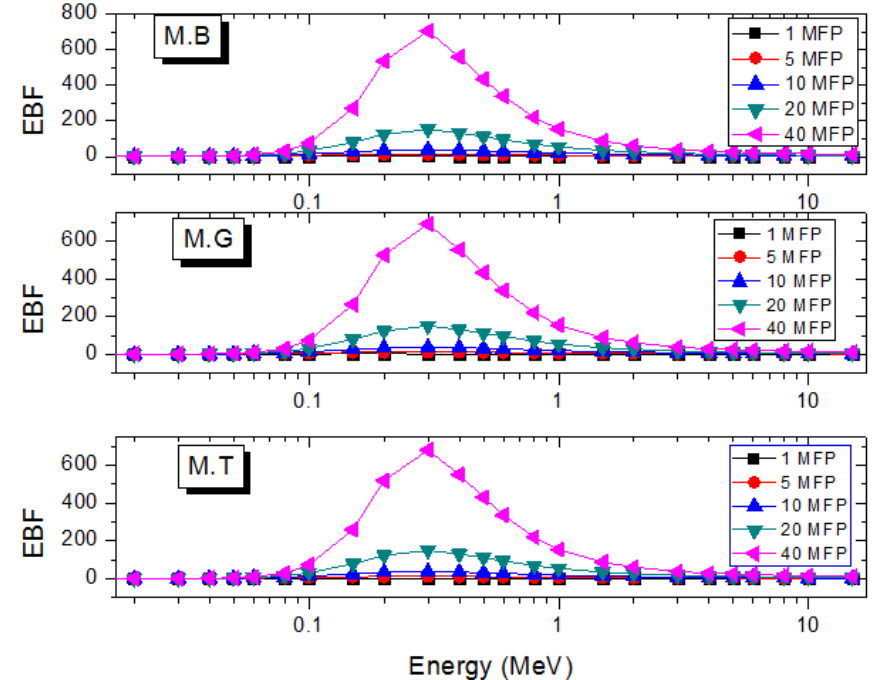
Figure 7. Variation of EABF of the marble samples with energy at selected depths.